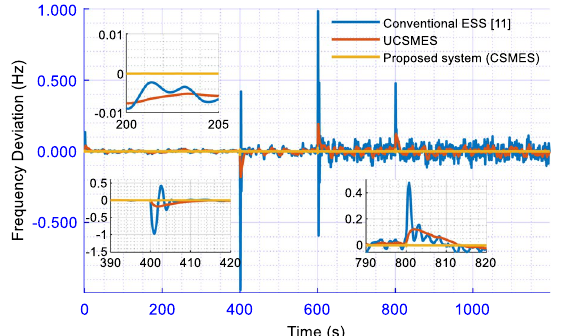
Fig. 14 Frequency deviation of the considered system for scenario B at 30% of system